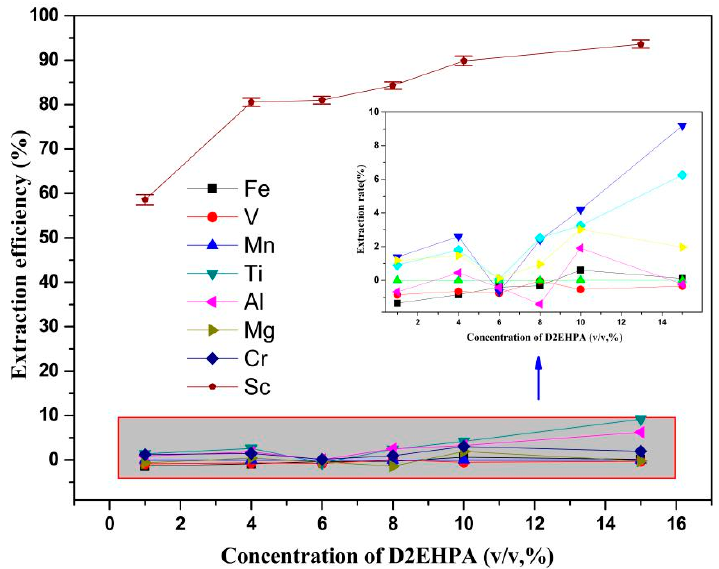
Figure 3. Effect of the di-(2-ethylhexyl) phosphate (D2EHPA) concentration on the Sc extraction (2%